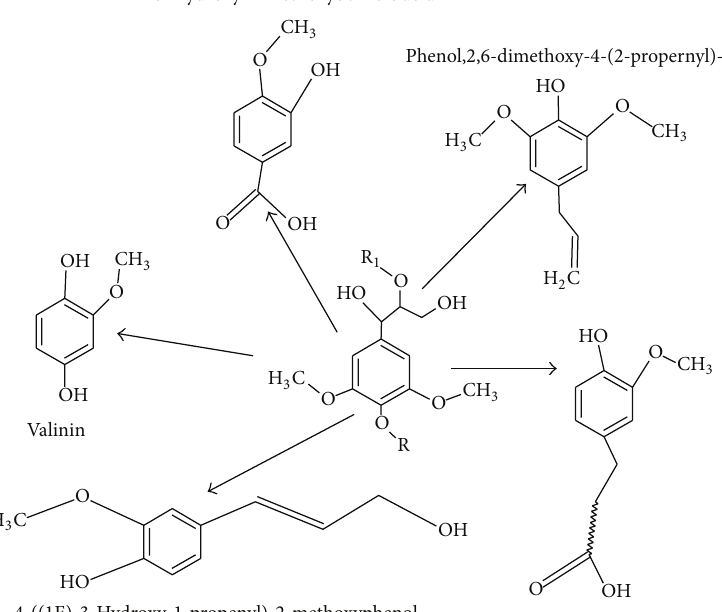
Figure 5: The schematic diagram of the lignin decomposition at low temperature ( < 773K).